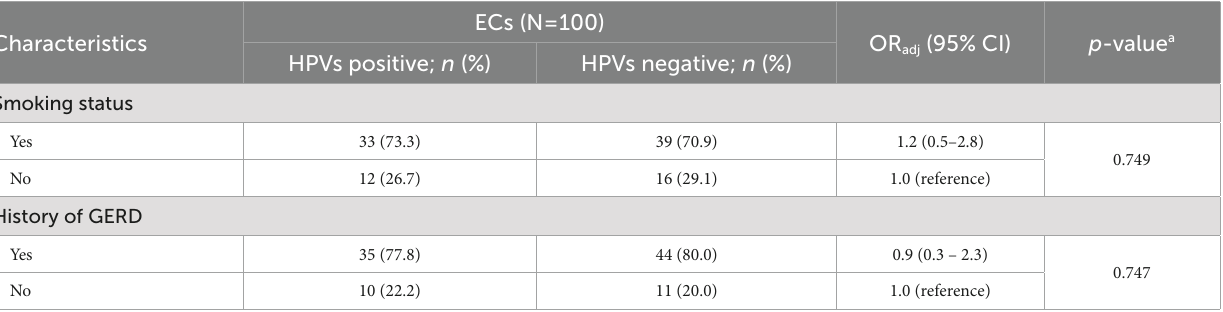
TABLE 4 The correlation of potential clinicopathologic findings and HPVs status in ECs.